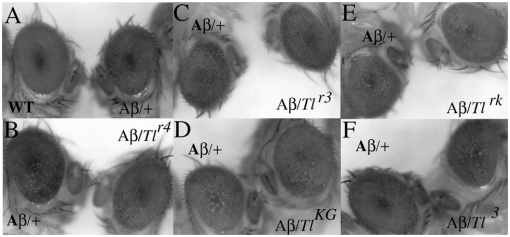
Aβ42 induced rough eye phenotype is sensitive to Toll activity.WT: Wild type flies. Aβ: pGMR-Aβ42 transgenic flies. In the experiments shown in this figure, the flies are hemizygous for the pGMR-Aβ42 transgene. Panel A: WT: eye of a wild type fly. Aβ/+: eye of a wild type fly hemizygous for the pGMR-Aβ42 transgene. Panels B through F show sibling pGMR-Aβ42 transgene flies that are either wild type Tl or heterozygous for the indicated Tl allele. Panel B: Aβ/+: hemizygous for the Aβ transgene; Aβ/Tlr4: heterozygous for the LOF allele Tlr4. Panel C: Aβ/+: hemizygous for the Aβ transgene; Aβ/Tlr3: heterozygous for the LOF allele Tlr4. Panel D: Aβ/+: hemizygous for the Aβ transgene; Aβ/TlKG: heterozygous for the LOF allele Tl KG03609. Panel E: Aβ/+: hemizygous for the Aβ transgene; Aβ/Tlrk: heterozygous for the LOF allele Tl rK343. Panel F: Aβ/+: hemizygous for the Aβ transgene; Aβ/Tl3: heterozygous for the GOF allele Tl r3.